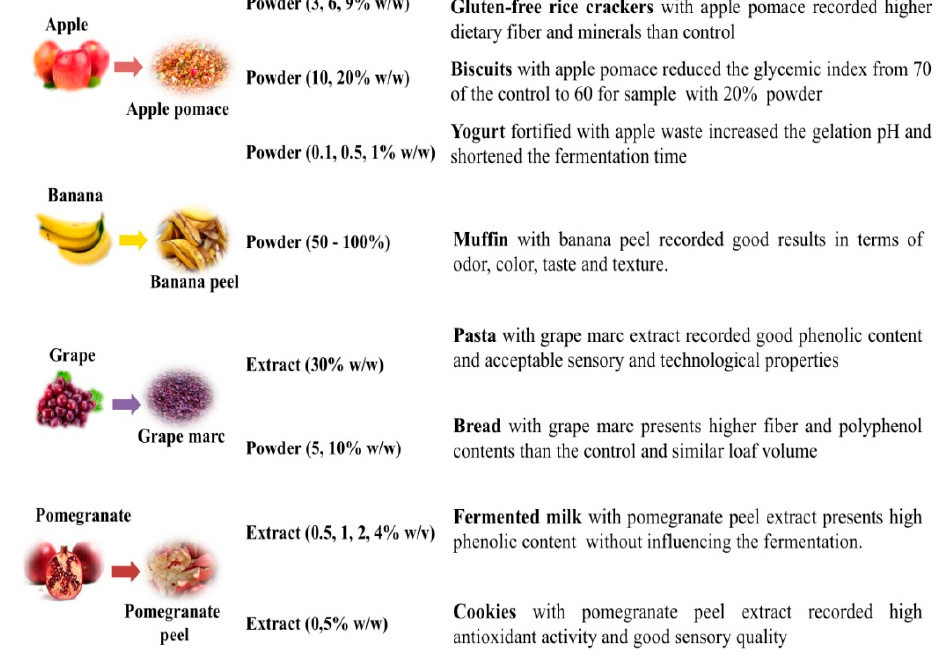
Figure 2. Applications of fruit by-products as food ingredients.